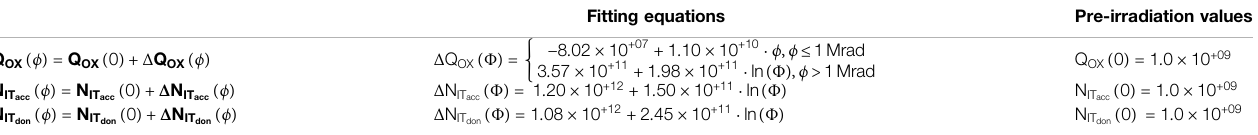
TABLE 4 | Fitting equations and pre-irradiation values for “ Perugia 2019 Surface ” modeling IFX 6 ″ silicon devices: oxide charge Q OX (cm − 2 ), acceptor interface trap states N ITacc (cm − 2 ), donor interface trap states N ITdon (cm − 2 ). Fitting equations Pre-irradiation values